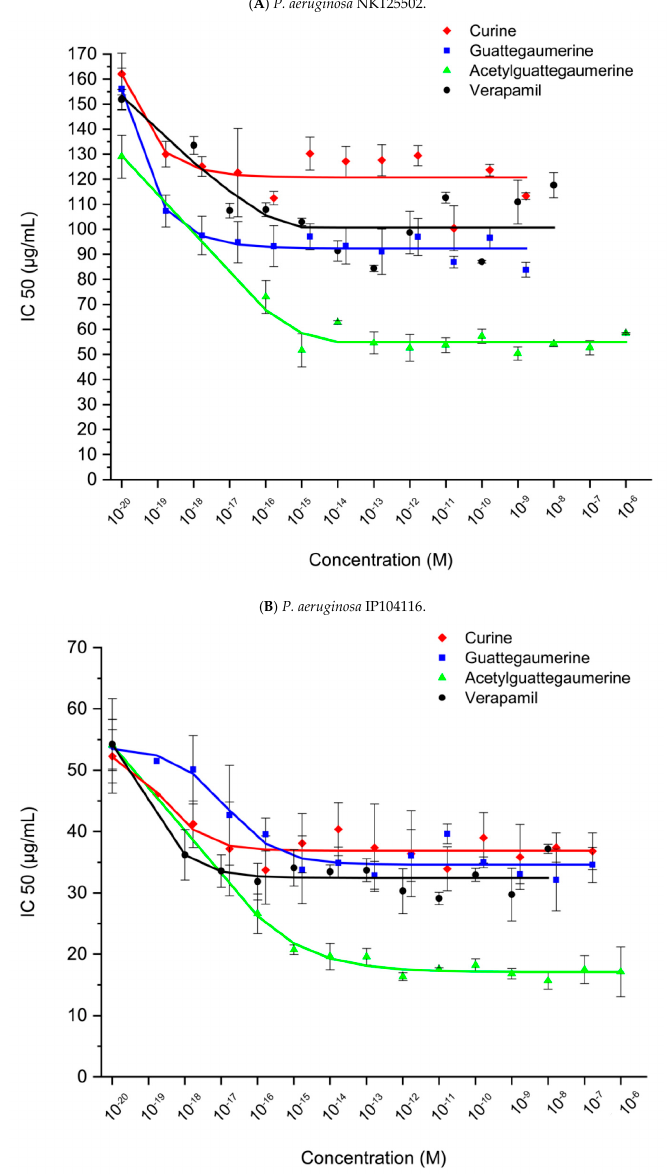
Figure 3. Effects of bisbenzylisoquinolines and verapamil on the sensitivity of P. aeruginosa NK125502 (clinical strain) ( A ) and IP 104116 (Pasteur Institute) ( B ) to carbenicillin. Bacteria were inoculated in 96-well plates with increasing concentrations of alkaloids (lines) and carbenicillin (columns) in 100 µL LB medium. After 24 h of incubation at 37°C, bacterial growth was estimated in each well and reported as growth without antibiotics for each alkaloid concentration. Relative growth was plotted against concentration in carbenicillin and IC50 was calculated for each concentration in alkaloids from the equation of the curve. Then, the obtained values were plotted against concentration in alkaloids (curine, guattegaumerine, tri-acetylguattegaumerine, and verapamil). The results are the mean values of at least four independent experiments. Figure 3A presents the IC50 variation in the clinical strain NK125502 after exposure to carbenicillin with increasing concentrations of curine, guattegaumerine, triacetylguattegaumerine, and verapamil. An increase in the sensitivity to the antibiotic was observed. The presence of the exopolysaccharide alginate did not prevent the bisbenzylisoquinolines from reaching their targets. Figure 3B shows an example of IC50 variation in the IP104116 strain after exposure to carbenicillin in the presence of the same alkaloids. It can be noted that the resistance of strain IP104116 to carbenicillin is reduced in the presence of alkaloids in the culture medium to reach a plateau for a concentration of 1 × 10 − 15 M. Beyond this concentration, the sensitivity to the antibiotic did not vary significantly, thus demonstrating the presence of a saturable system sensitive to these alkaloids.